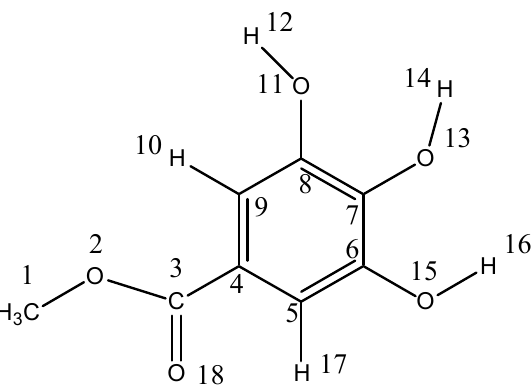
Figure 1. Structure and atomic numbering of methyl gallate.